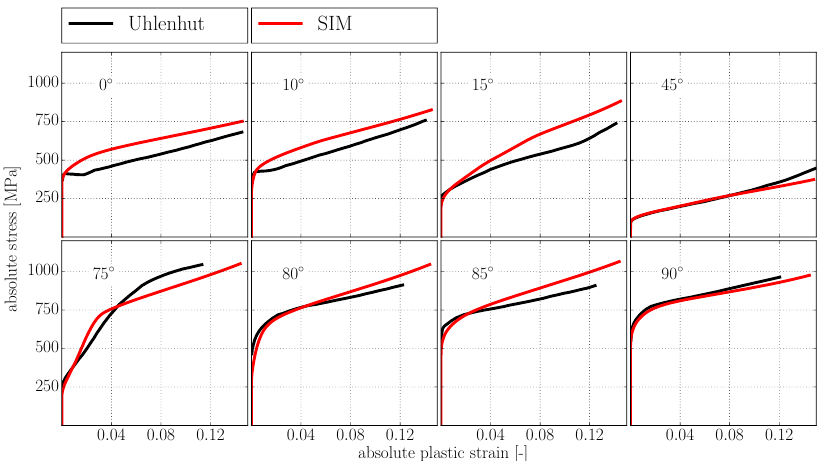
Figure 8. Orientation dependent yield and hardening behavior of polysynthetically twinned crystals. Experimental results taken from [9].